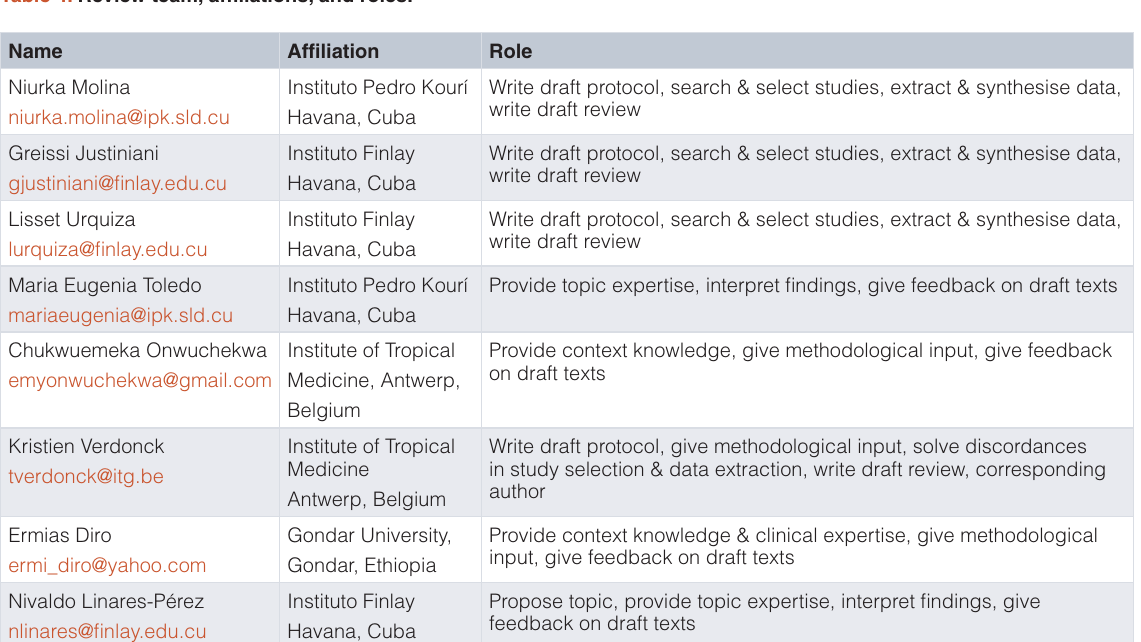
Table 4. Review team, affiliations, and